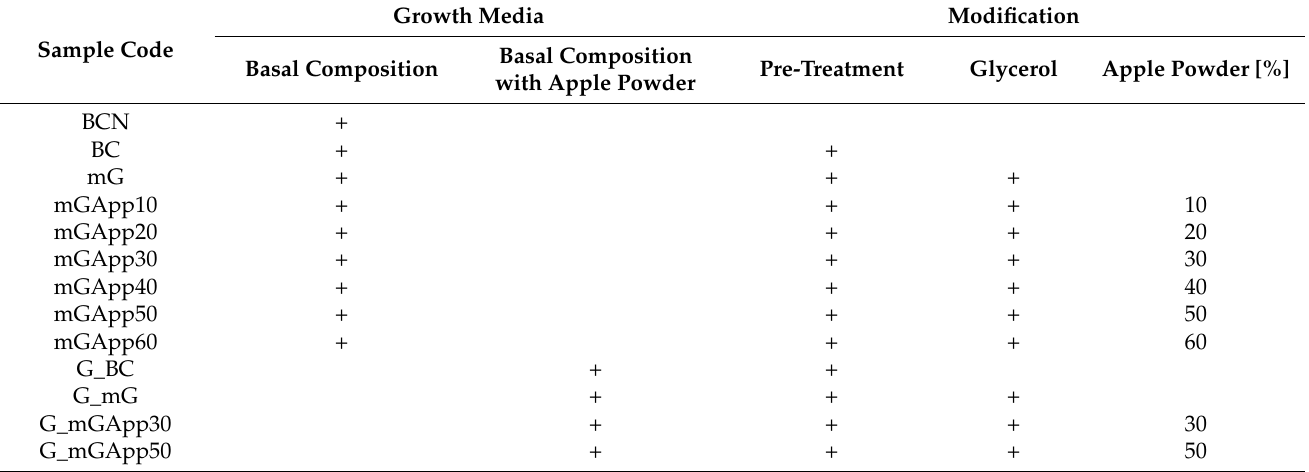
Table 2. The conditions used to produce bacterial cellulose and its subsequent modification.